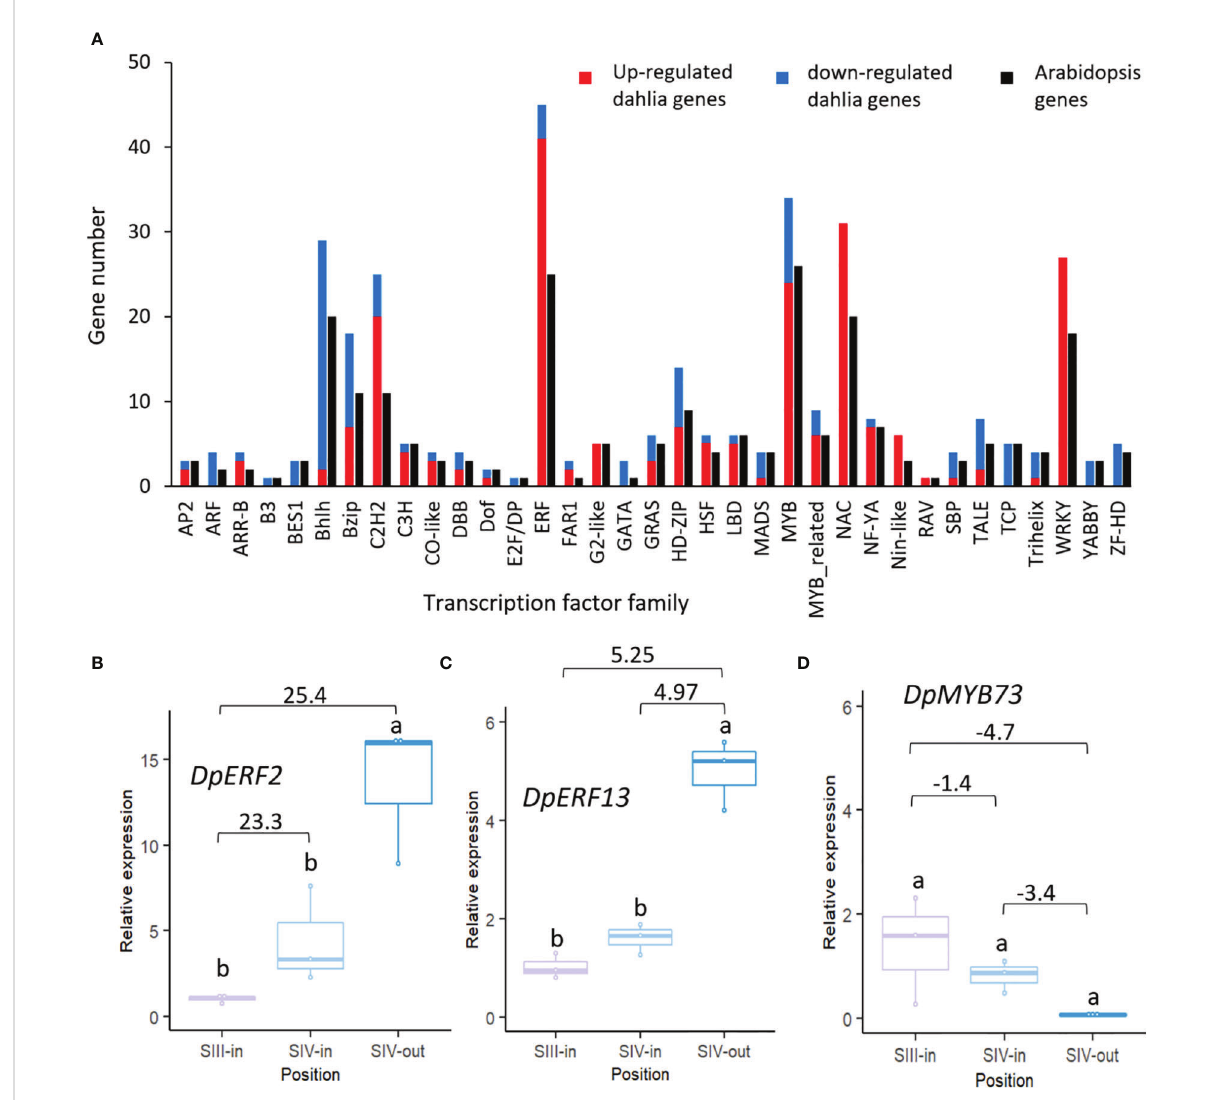
FIGURE 5 Transcription factors differentially expressed in at least one dahlia fl oret stage comparison. (A) Numbers of genes of each family amongst the DEGs in the dahlia transcriptome and number of nearest Arabidopsis gene homology match. Red and blue indicate numbers of genes in each family that were all up or down regulated, respectively; (B – D) RT-qPCR analysis of (B) DpERF2 (C) DpERF13 (D) DpMYB73 , n=3, different letters indicate signi fi cant differences p < 0.05, based on a 2-way ANOVA followed by a Tukey ’ s test or a Kruskall Wallis test followed by a Dunn ’ s post hoc test if the data did not fi t the normality and equal variance criteria required. RNA seq log2FC shown on